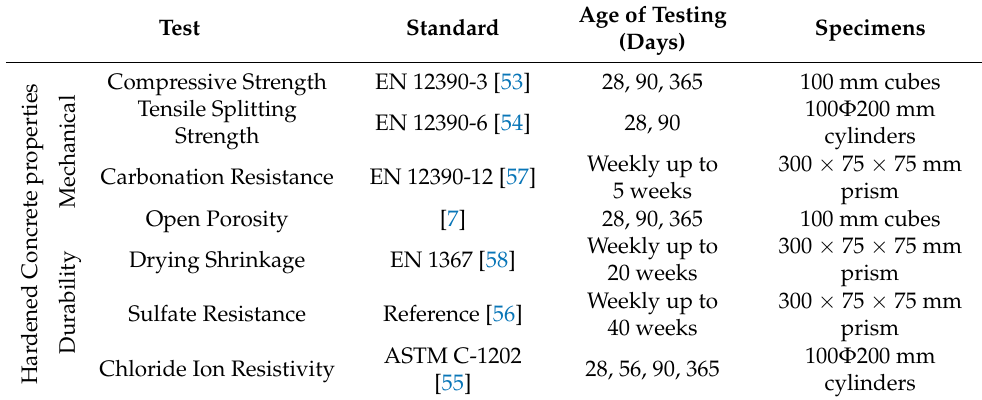
Table 2. Experiments, age of testing, specimen size and standards used in the experimental program. Age of Testing Test Standard (Days)